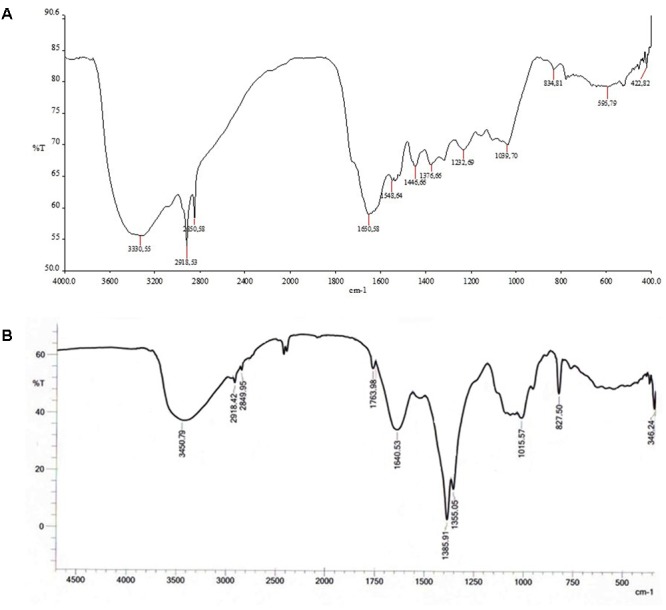
Fourier transform infrared (FT-IR) spectrogram of (A) BuPC and (B) green synthesized ZnOPC.